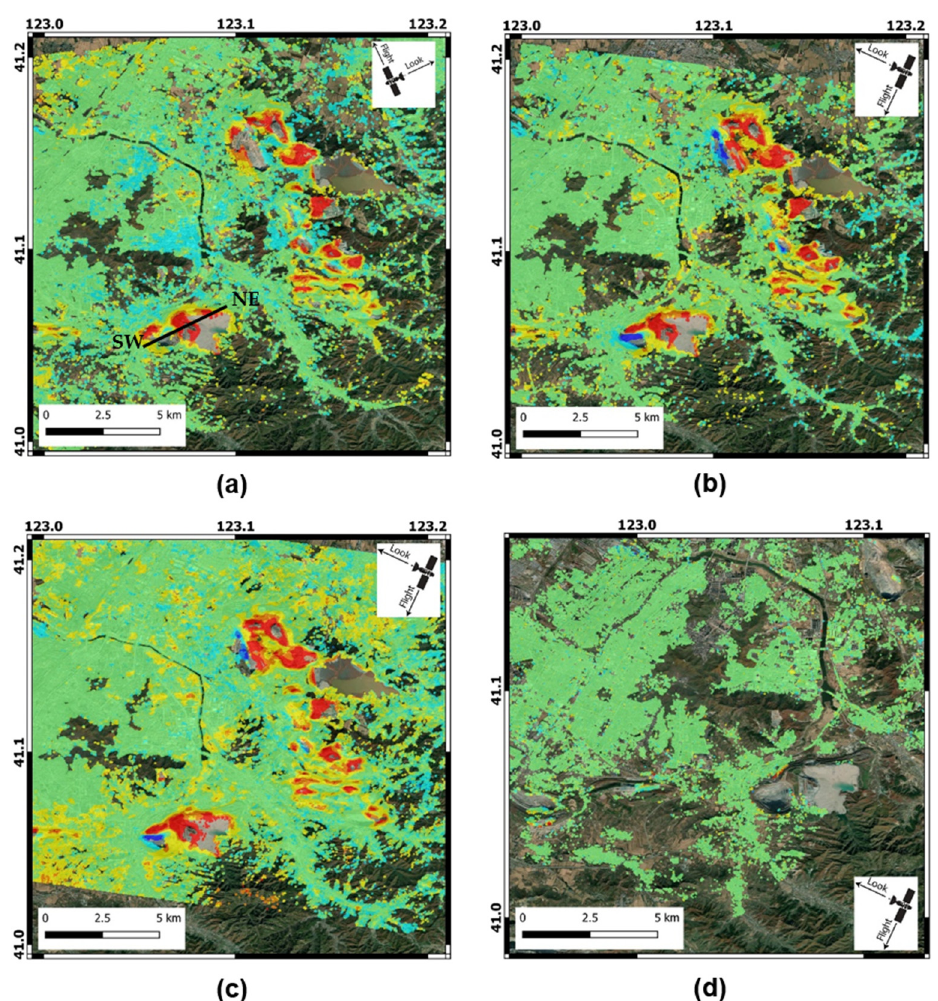
Figure 9. Ground velocity maps for the Anshan pit mine area: ( a ) S1 ascending on path 25; ( b ) S1 descending on path 105. Black line represents the profile plotted in Figure 3; ( c ) S1 descending on path 3; ( d ) COSMO-SkyMed (CSK) descending orbit. Note that CSK map has a different colour bar and different spatial scale and layer extent because of the CSK frame.